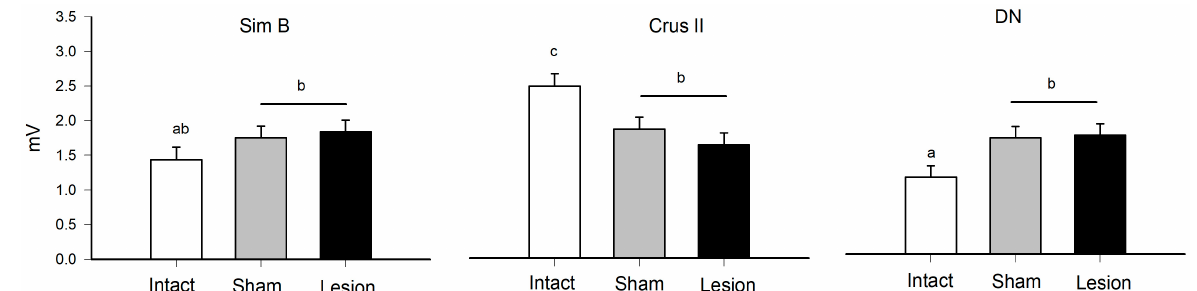
Figure 6. Average value (mean ± SE) of the maximum amplitude (mV) during vertical exploration of the Sim B, Crus II structures, and the dentate nucleus in the intact, sham, and lesion groups. The bifferent letters on the bars (a, b, and c, α = 0.05) contrast in multiple comparisons by Tukey’s method for the means recorded in the groups of rats and structure that were delimited by the effect of the interaction corresponding to the statistical model (Table 3). Table 3. Effects test for vertical exploration behavior. Results of nested ANOVA for the effect of traces (T), rat (R), structure (S), group (G), and probability of differences based on F values and r 2 = 0.32 of the model. The animals used were made in independent groups.